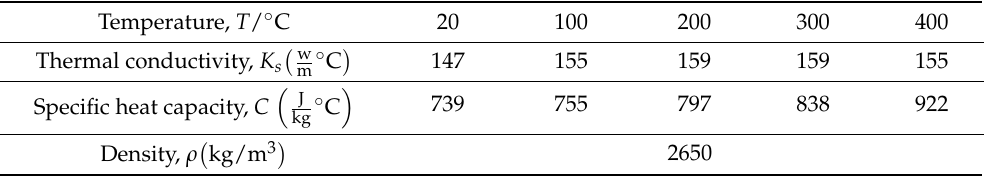
Table 2. Thermophysical parameters of AlSi10Mg alloy.